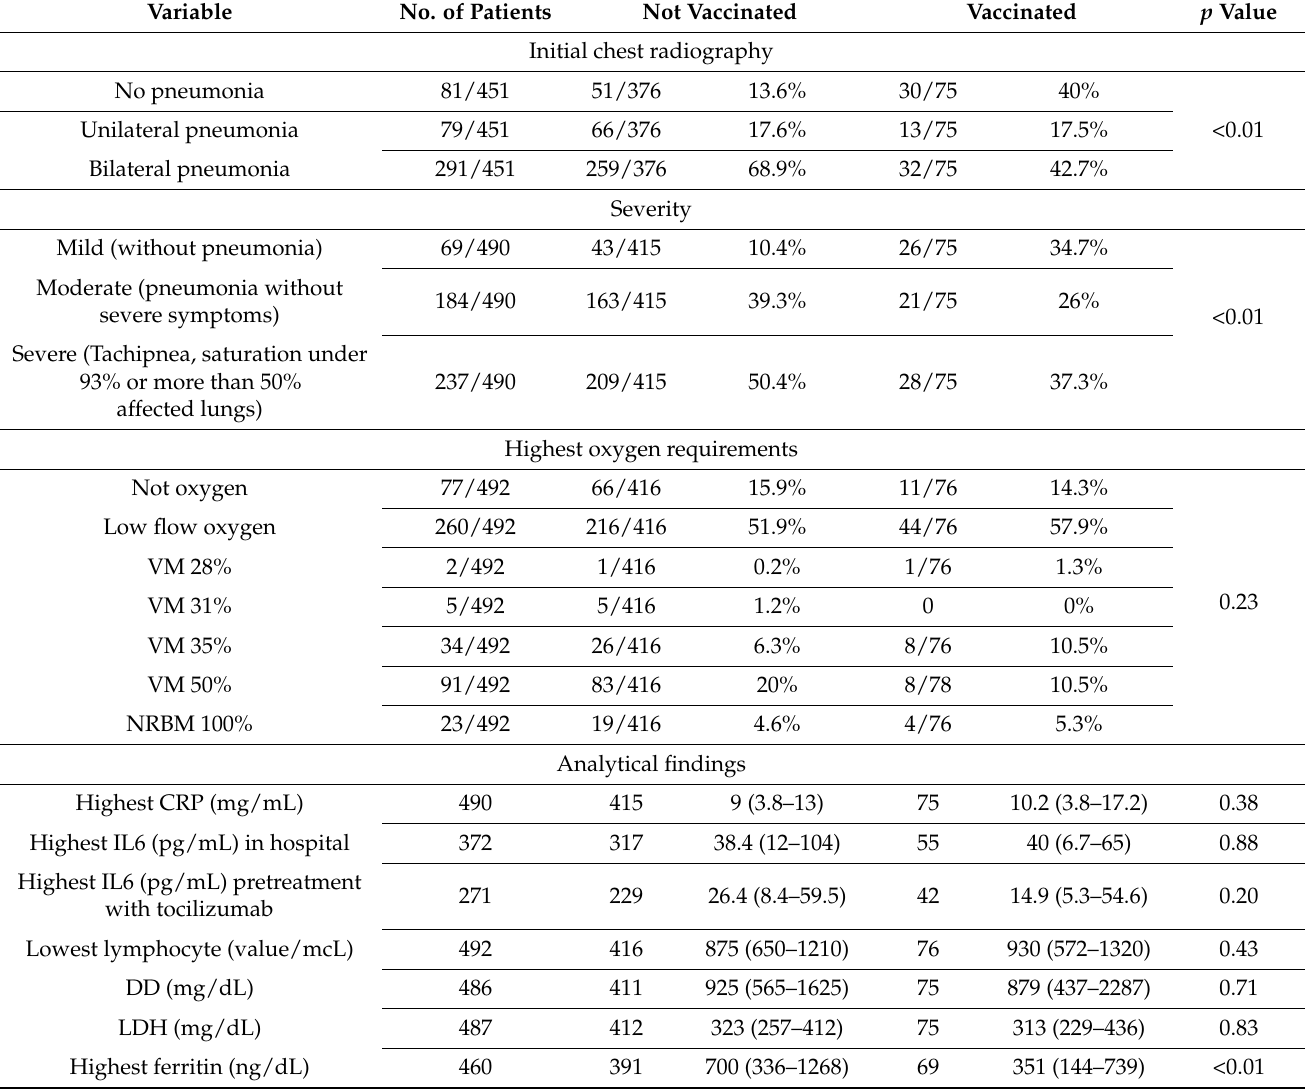
Table 3. Clinical characteristics in the not vaccinated and vaccinated cohorts